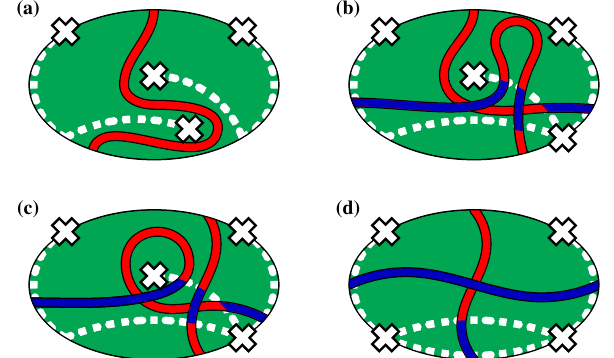
FIG. 7. A sequence of code deformations that map the logical ¯ Z ¯ Y operator onto .(a)We move thebottomtwotwistdefects intothe ¯ Z centerofthe lattice.We alsoshowthe stringoperatorinred,which “ snakes ” between the twist defects at the center of the lattice. (b) We deform the position of one twist defect into the bottom-right corner of the lattice. The logical operator is deformed over the defect line such that it is not supported on any of the qubits where code- deformation measurements move the lowest twist defect from its position in (a) to its position in (b). This deformation moves the logical operator over a defect line and, as such, changes the color of the string. We also multiply the logical operator by a stabilizer that extends from the left-hand side of the lattice to the bottom of the lattice, which is also shown in the figure. (c) A small deformation of the logical operator shown in (b) gives the pictured logical operator. (d) Multiplying the logical operator shown in (c) by a stabilizer that encloses the single twist defect lying at the center of the lattice deforms the logical operator out of the path of the twist, enabling us to move the twist defect at the center of the lattice to the bottom-left corner of the lattice, thus completing the